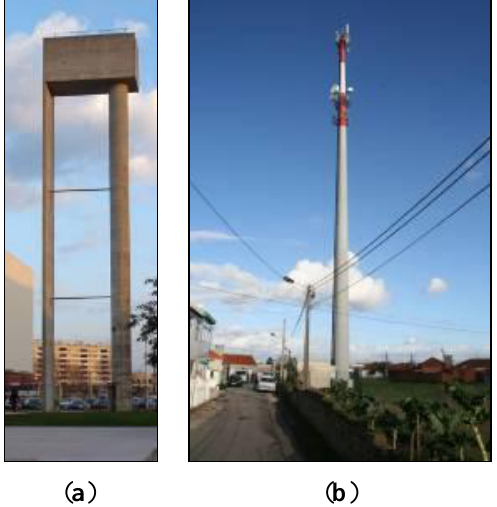
Figure 4. Photographs of the University of Aveiro water reservoir ( a ) and telecommunication tower ( b